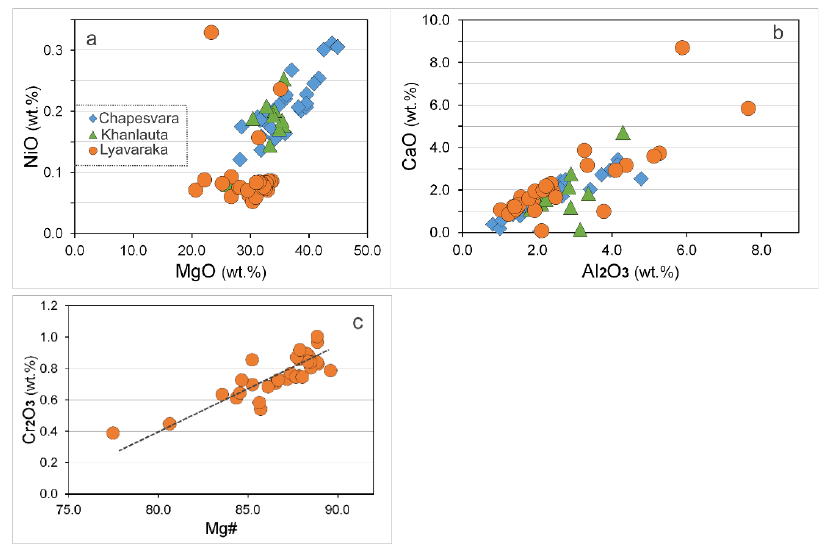
Figure 13. ( a – c ). Plot of contents of MgO vs. NiO in wt.% ( a ), Al 2 O 3 vs. CaO in wt.% ( b ), and values of the Mg# vs. contents of Cr 2 O 3 in wt.% ( c ), in ultrabasic rocks of the Lyavaraka complex (orange symbols), compared with the Chapesvara sill [12] (blue diamonds) and the Khanlauta differentiated flow [13] (green triangles).